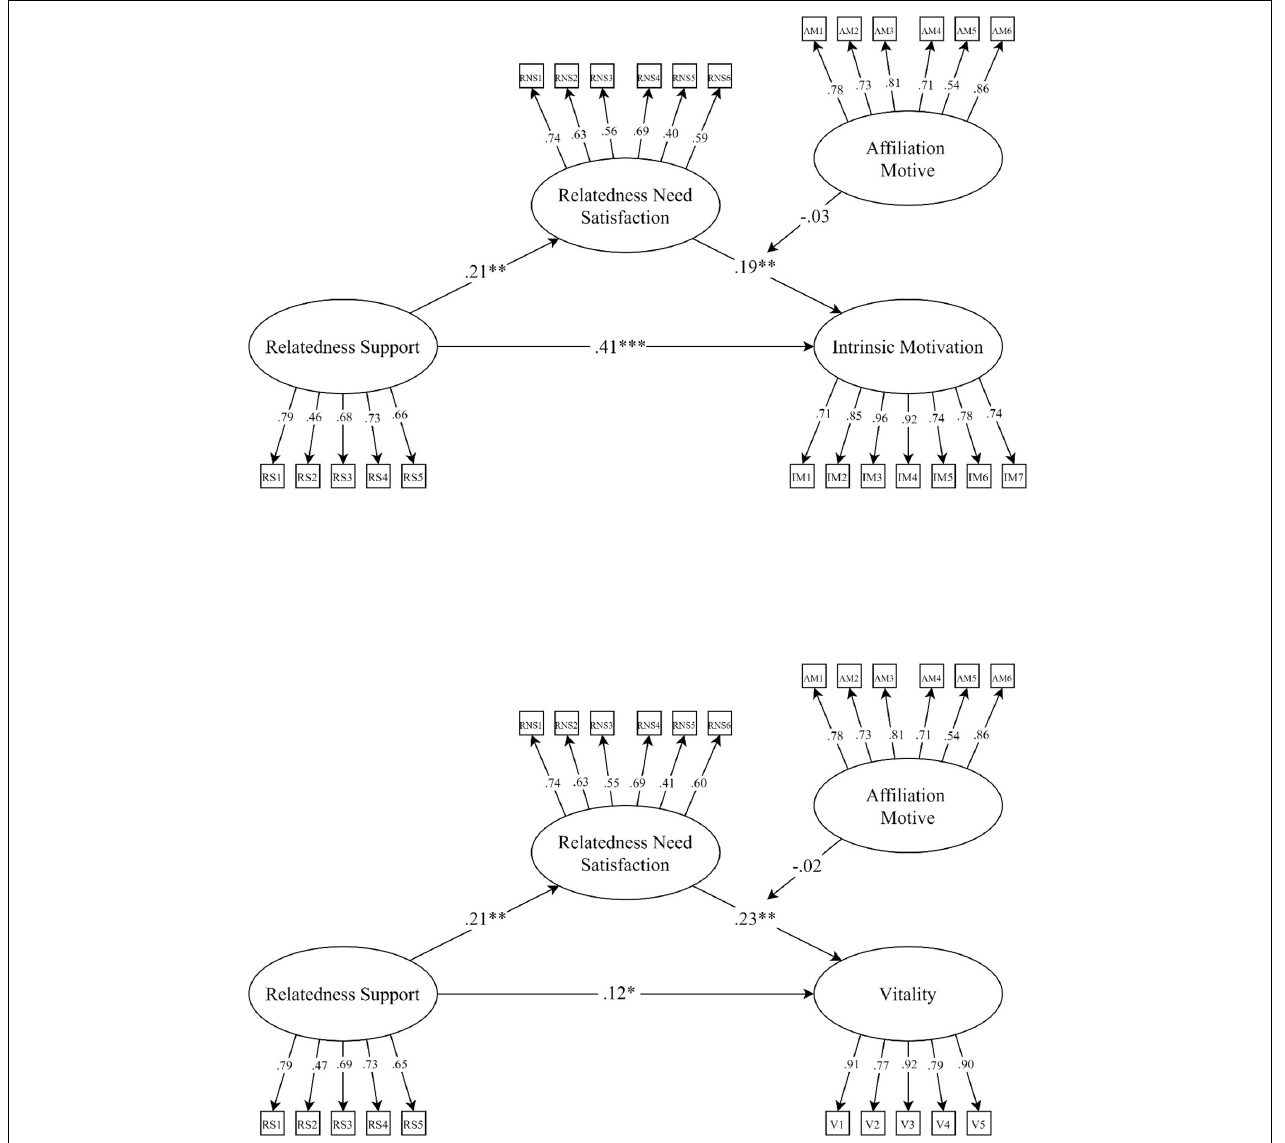
FIGURE 3 | The moderating role of the affiliation motive between relatedness satisfaction and intrinsic motivation and vitality with standardized coefficients. ∗ p ≤ 0.05, ∗∗ p ≤ 0.01, ∗∗∗ p ≤